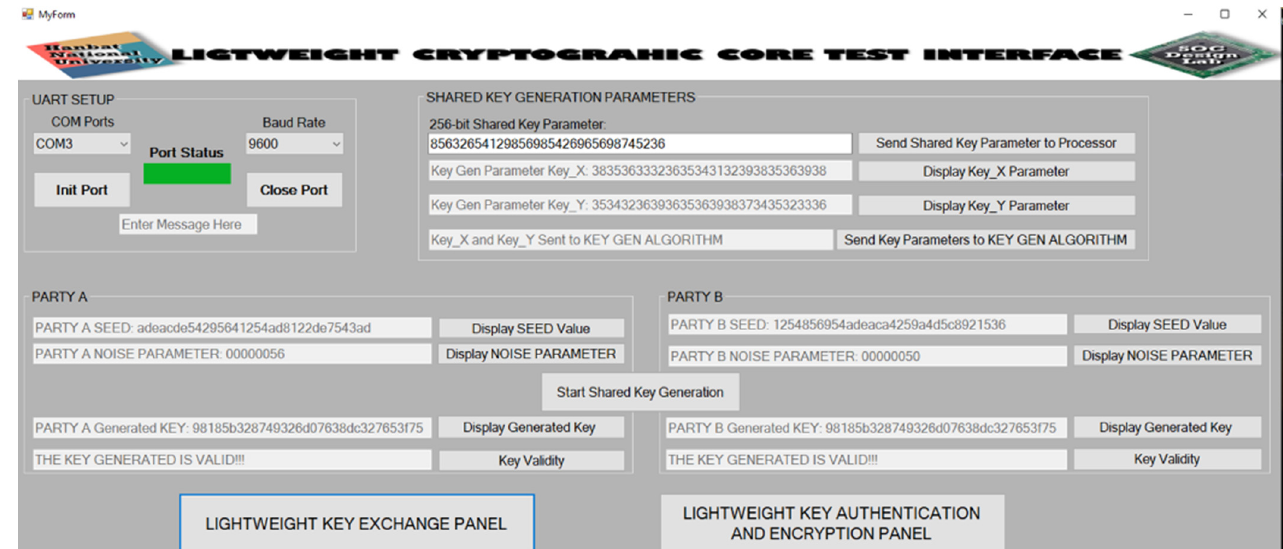
Figure 23. GUI of the lightweight key authentication and encryption/decryption panel.